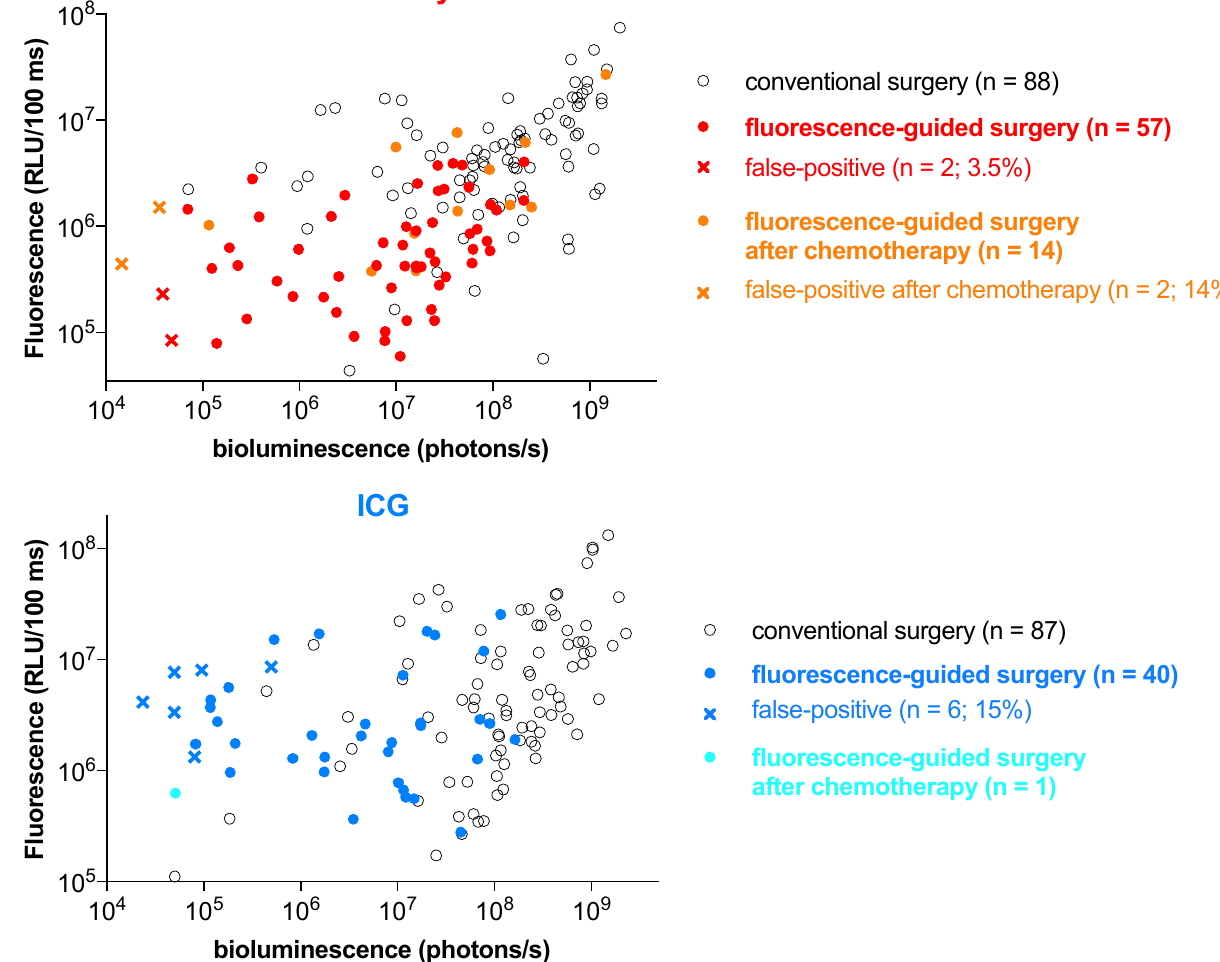
Figure 5. Angiostamp800 and Bevacizumab-IRDye 800CW showed fewer false-positive fluorescent signals than ICG. All fluorescent surgical nodules from mice with peritoneal carcinomatosis without or after chemotherapy were analyzed ex vivo by bioluminescence to determine their tumor status. Nodules with low or no bioluminescence signals were further analyzed to quantify luciferase expres- sion by measuring the presence of tumor cells. Data show a correlation between the bioluminescence and fluorescence of samples resected by conventional surgery (open black dots) or fluorescence- guided surgery (colored plain dots). Fluorescent nodules with a negative bioluminescence signal were considered false positives (colored crosses). The number of resected nodules and the percentage of false-positive residues is indicated for each probe, except for fluorescence-guided surgery with ICG after chemotherapy, which failed to resect additional tumor nodules because of the blurred fluorescence signal from ICG.